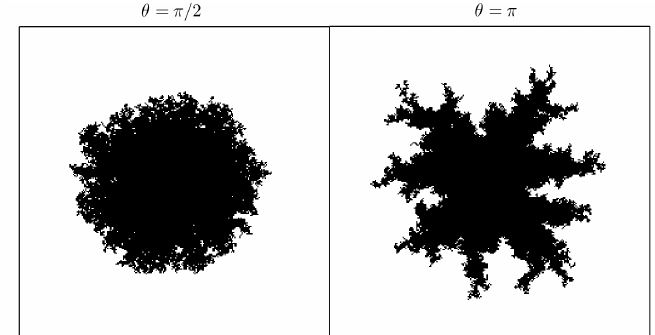
Figure 5. Shape at y = 0.25 (i.e., 25% of total occupied area, see Equation (3)) of 1 crystallization nucleus for opening angle θ = π /2 and θ = π , taking α = 0.8, β = 1, r inf = 32 and n = 256. The greater the angle θ is, the bigger the “fjords” are. The simulations were carried out setting C except for one cell in the